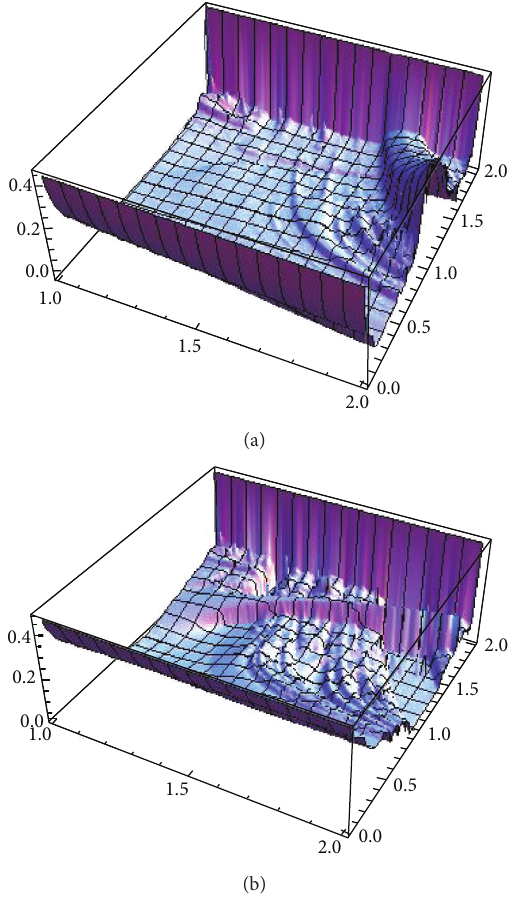
Figure 15: Average profits of firm 1 (a) and firm 2 (b) for 𝑛 = 10000 and step size for parameters 𝛼 and 𝛽 equal to 0.01. The initial conditions are 𝑥 0 the maximum of 𝑓 𝛼 ∘ 𝑔 𝛽 and 𝑦 0 the maximum of ∘ 𝑓 𝑔 𝛽 𝛼 (type